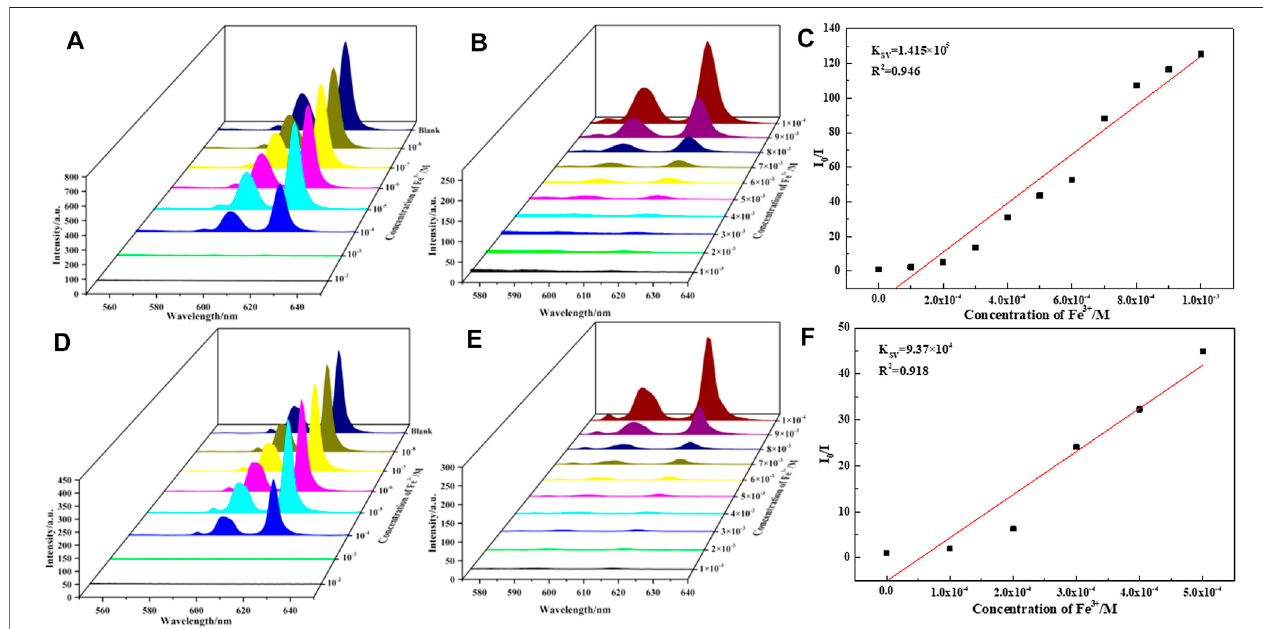
FIGURE 5 | (A,D) are luminescence spectra of 1 and 5 dispersed in aqueous solutions of FeCl 3 (10 − 2 – 10 − 8 M, 10 ml H 2 O, 2 mg 1 and 5 ), respectively. (B,E) are luminescence spectra of 1 and 5 dispersed in aqueous solutions of FeCl 3 (10 − 3 – 10 − 4 M, 10 ml H 2 O, 2 mg 1 and 5 ), respectively. (C,F) are linear dependence between the quenching ef fi ciency and the concentration of Fe 3+ in the range of 0.1 – 1 mM,